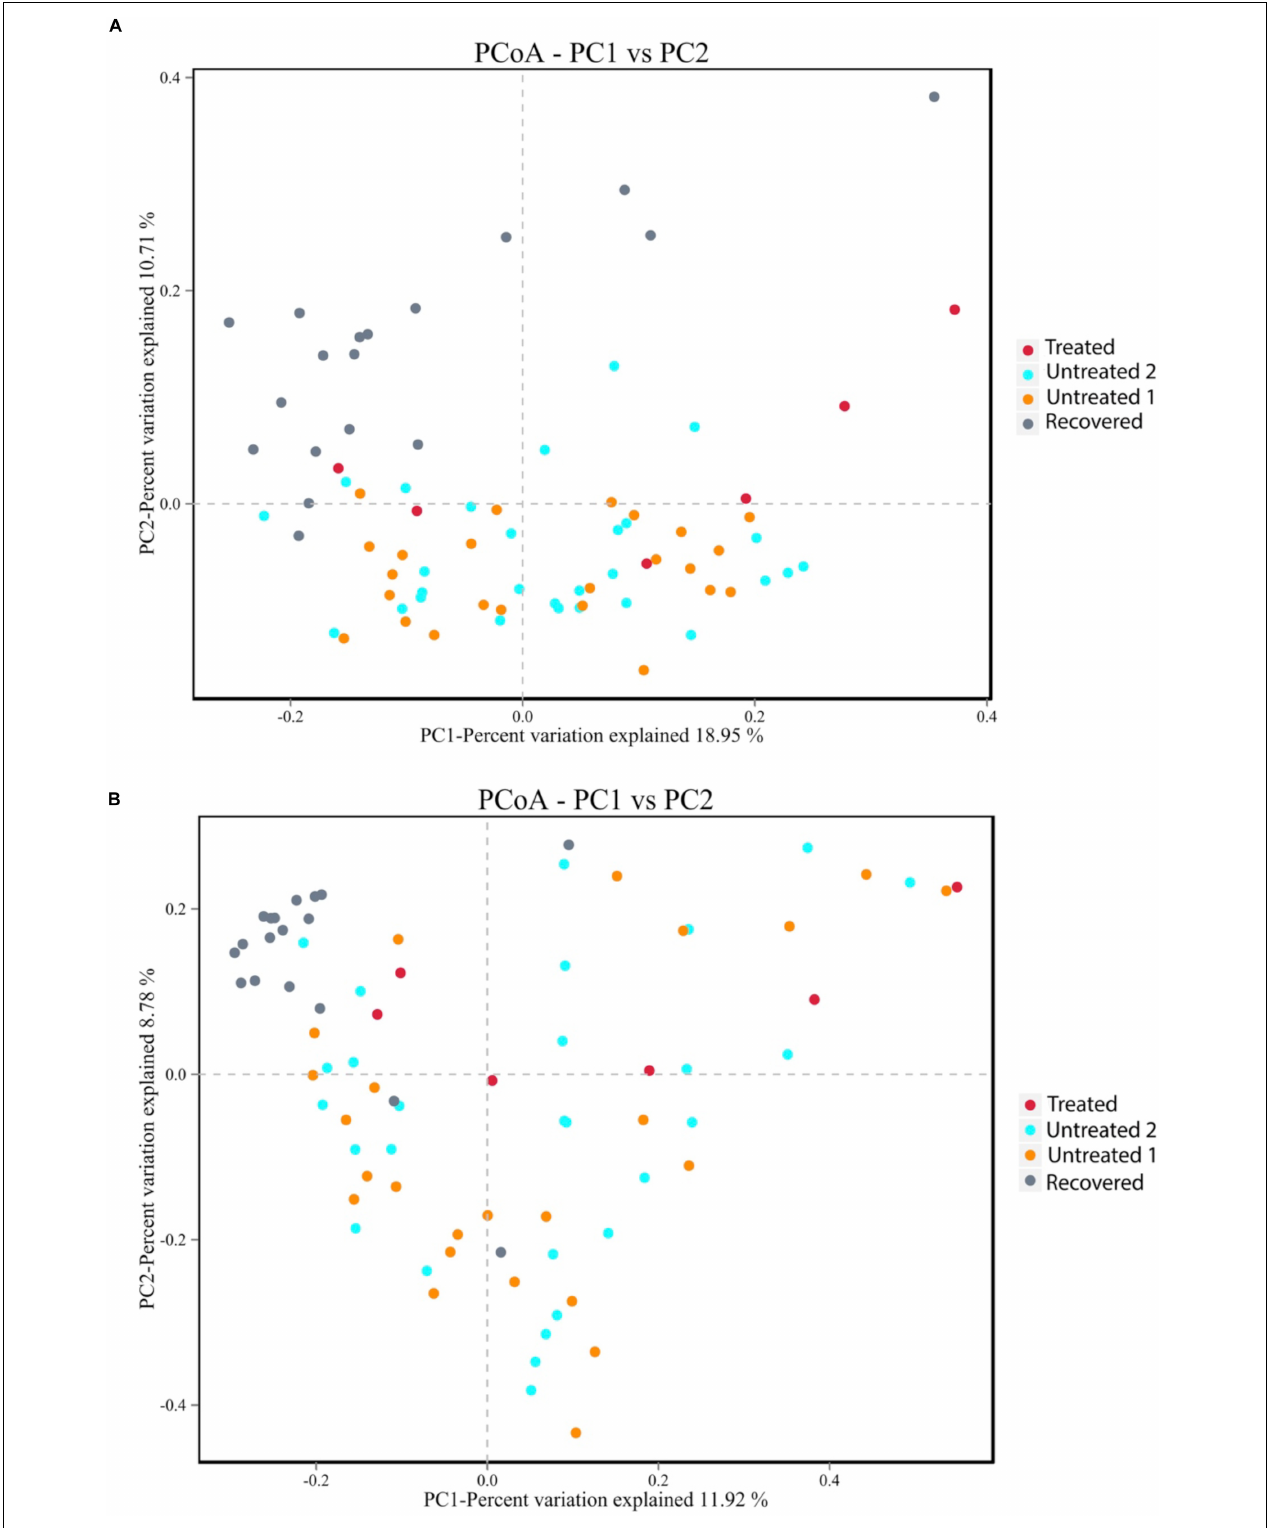
FIGURE 2 | Principal coordinate analysis plot based on (A) the unweighted UniFrac distance at the operational taxonomic unit (OTU) level and (B) the Bray-Curtis dissimilarity at the OTU level. Untreated group 1 and untreated group 2 are the sex and age matched controls for the multi-drug-resistant tuberculosis (MDR-TB) treated group and the MDR-TB recovered group,